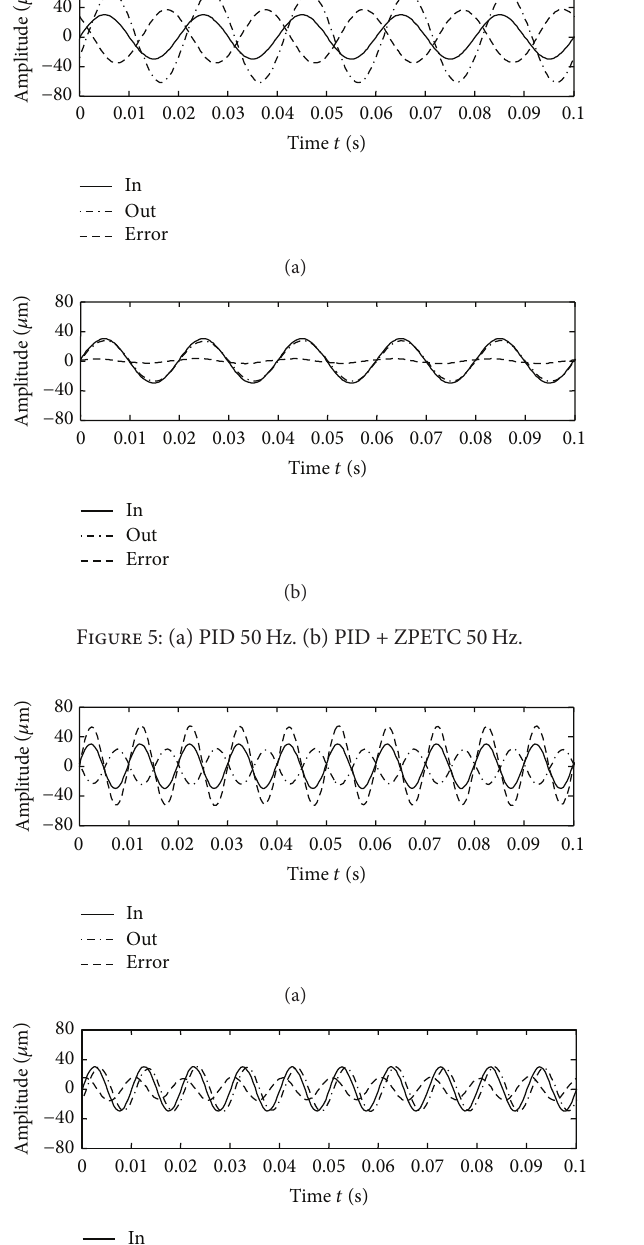
At this time the system should be near the inflection point in the closed-loop frequency response. Under 100 Hz, the phase of system response lags almost 180 degrees, so the max tracking error increases to 184.3% of the amplitude of input sinusoidal signal.